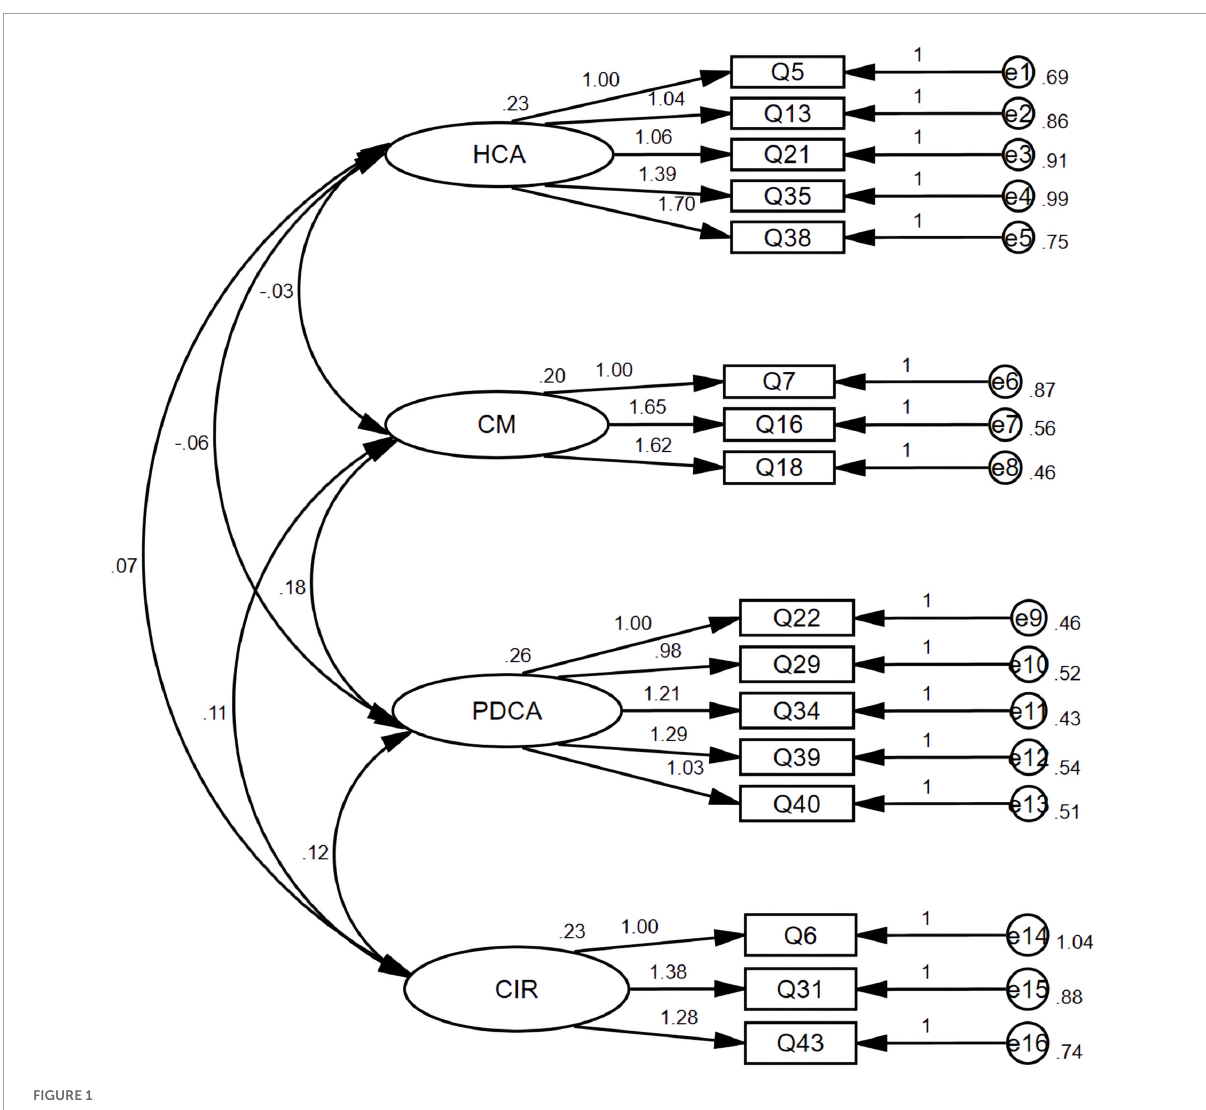
FIGURE1 Confirmatory factor analysis of CPS-CS, the four-factor model.